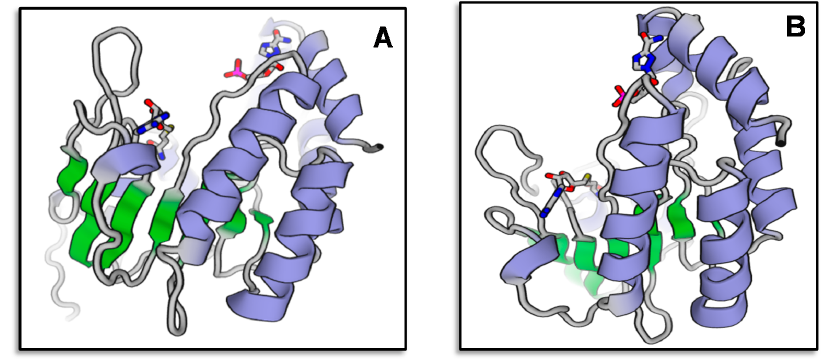
Figure 4. The computational modeled three dimensional structure of muscadine MybA1 ( A ); and MYBCS-1 ( B ).